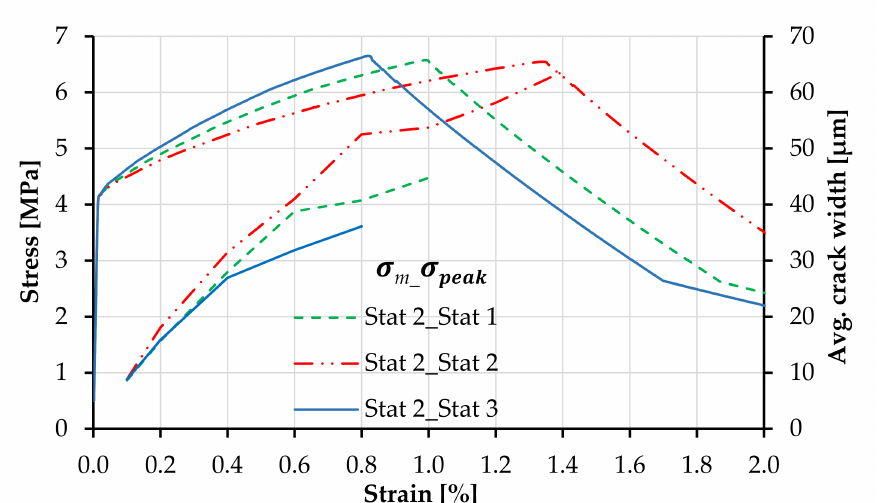
Figure 10. Tensile stress–strain curves corresponding to plain SHCC with different distribution functions of tensile strength and constant distribution function of matrix strength.